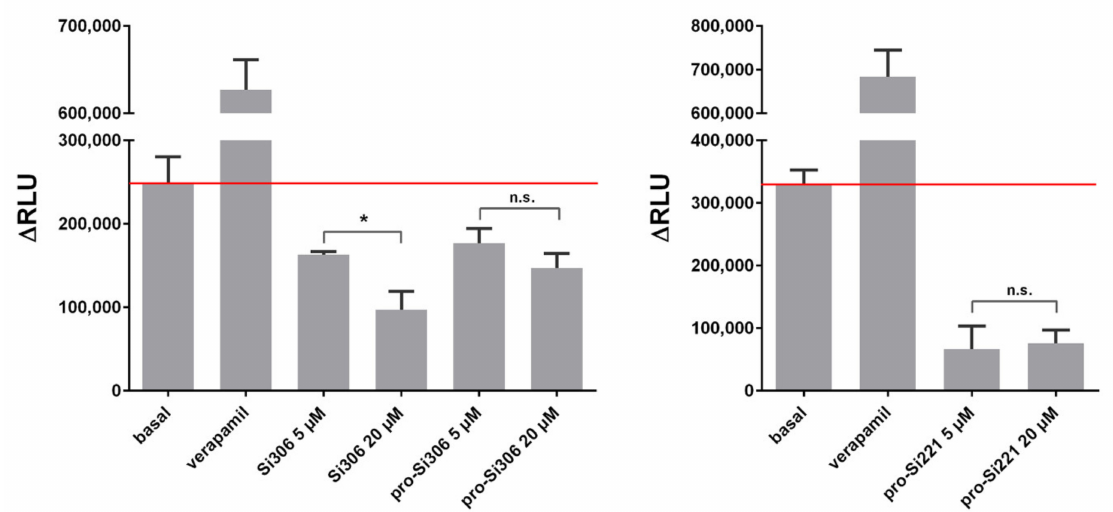
Figure 4. SFK inhibitors affect the ATPase activity of P-gp. The samples were treated with 5 µ M and 20 µ M Si306, pro- Si306, and pro-Si221. Verapamil was used as a positive control. The y -axis represents the difference in relative light units ( ∆ RLU) between Na3VO4-treated samples and samples treated with the tested compounds. ∆ RLU basal is the difference in the luminescent signal between Na3VO4-treated and untreated samples. The results are expressed as the mean ± SEM. Statistically significant differences between 5 µ M and 20 µ M treatments with Si306, pro-Si306, and pro-Si221: p < 0.05 (*), not significant